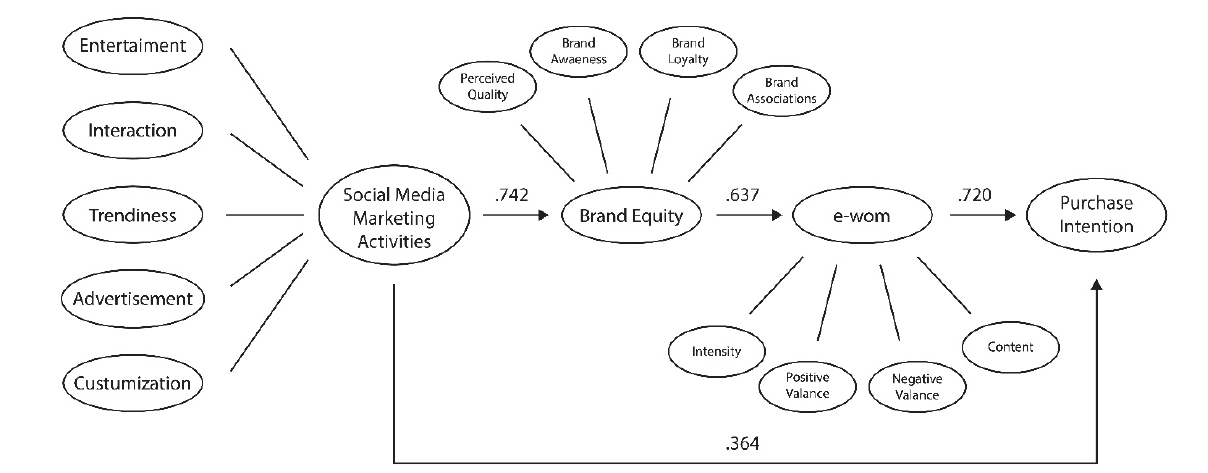
Fig. 2. Confirmatory Factor Analysis